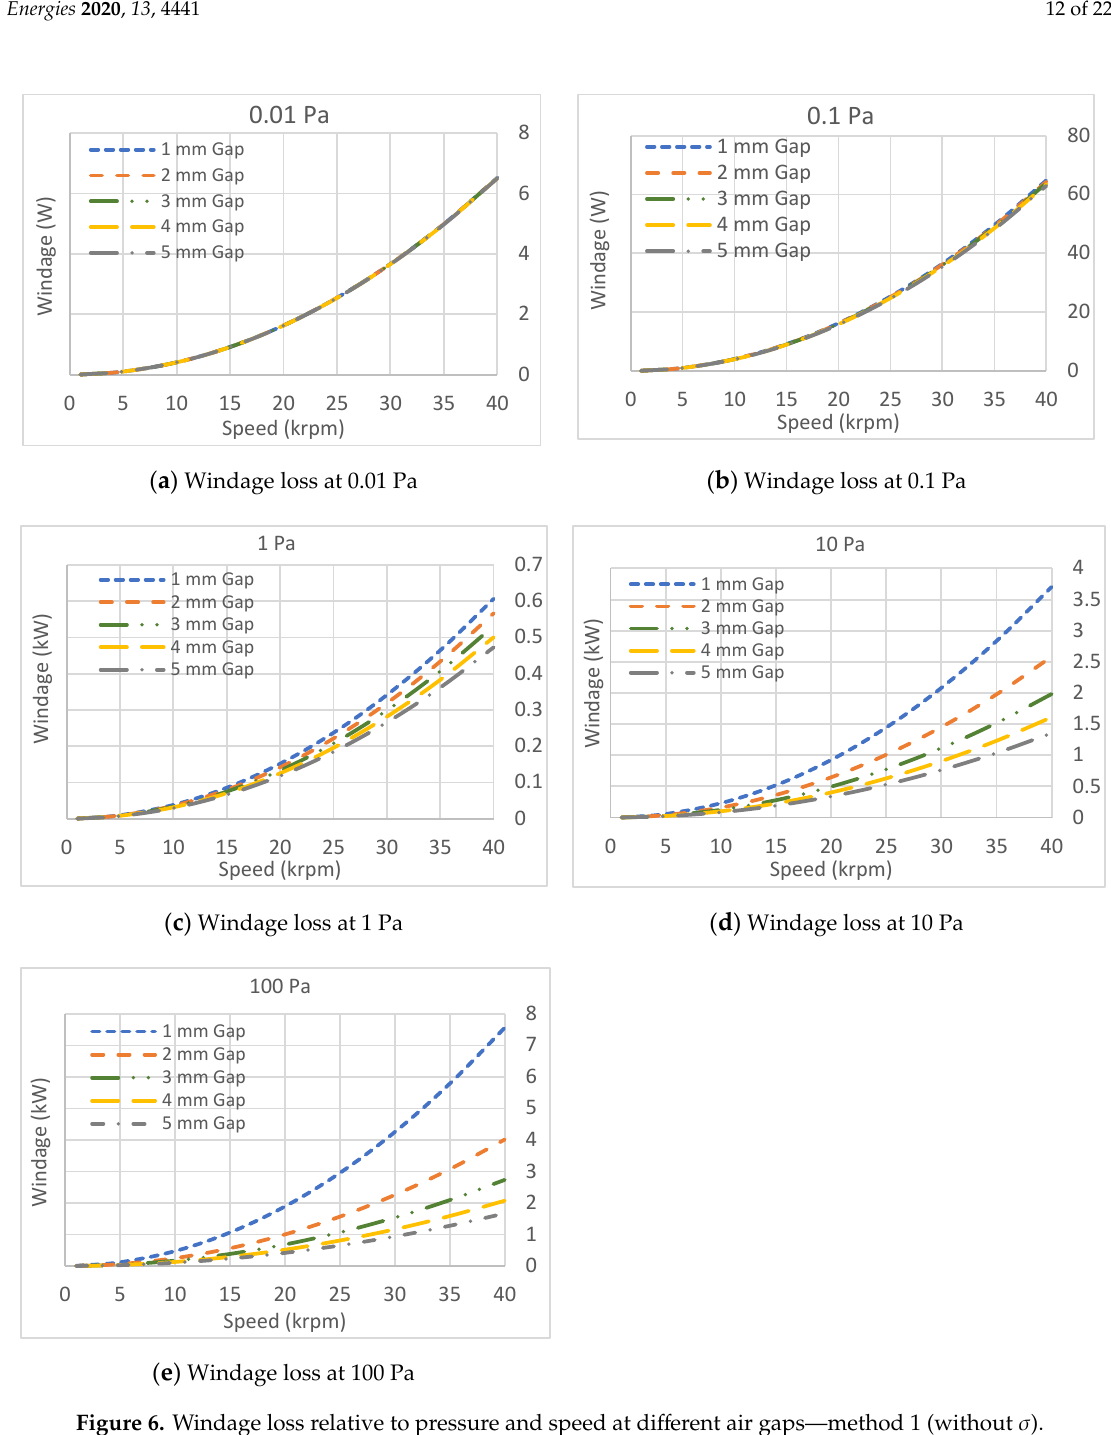
Figure 6. Windage loss relative to pressure and speed at different air gaps—method 1 (without 𝜎 )